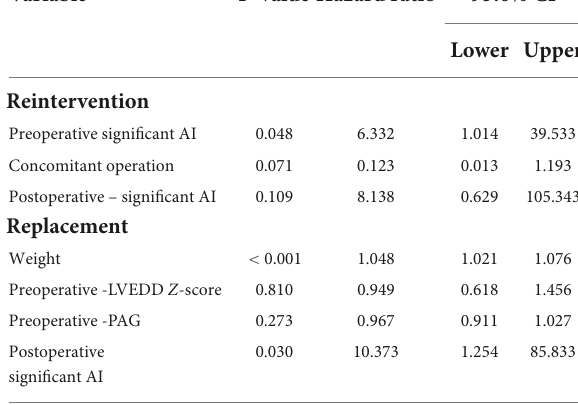
TABLE 4 Risk factors for reintervention and replacement by competing risk regression